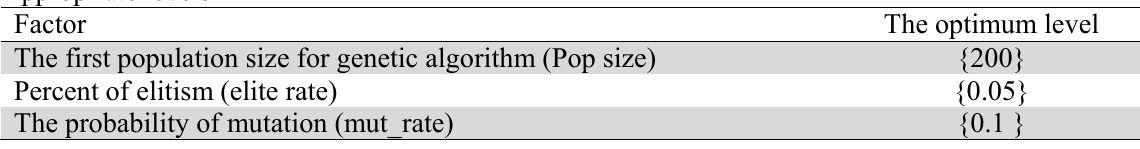
Appropriate levels Factor